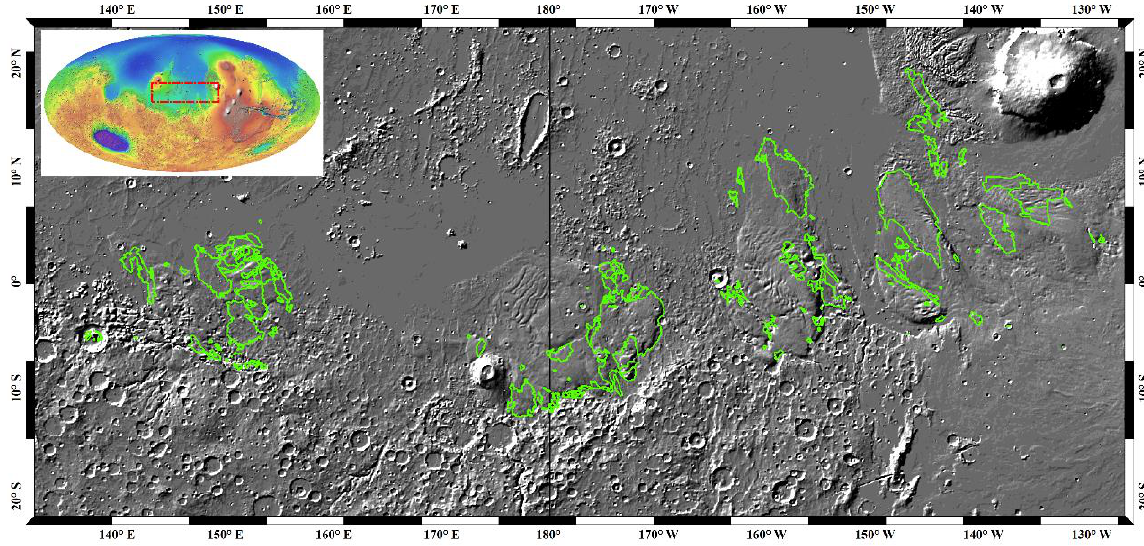
Figure 2. The yardangs in the MFF. The background is a MOLA hillshade relief map (128 pixels/degree). The green polygons are the yardang fields in the MFF [7].